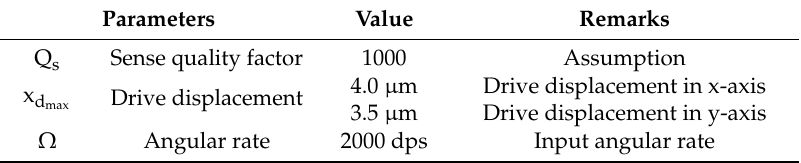
Table 3. Sense-mode analysis parameters for the proposed single-drive, 3-axis MEMS